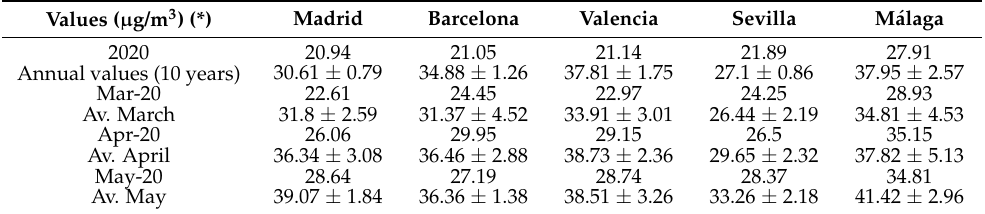
Table 2. Comparison of tropospheric ozone values in 2020 and the 10 years of data series. Av. = average. Values ( µ g/m 3 ) (*)